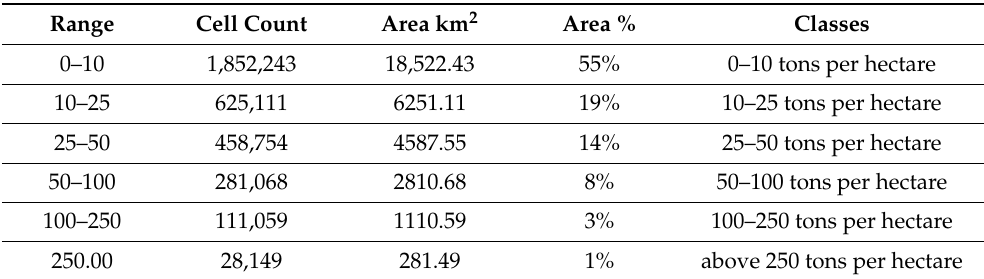
Figure 8. Erosion risk map of the entire watershed. Table 3. Classification of soil erosion of Jhelum watershed concerning the area. Table 3. Classification of soil erosion of Jhelum watershed concerning the